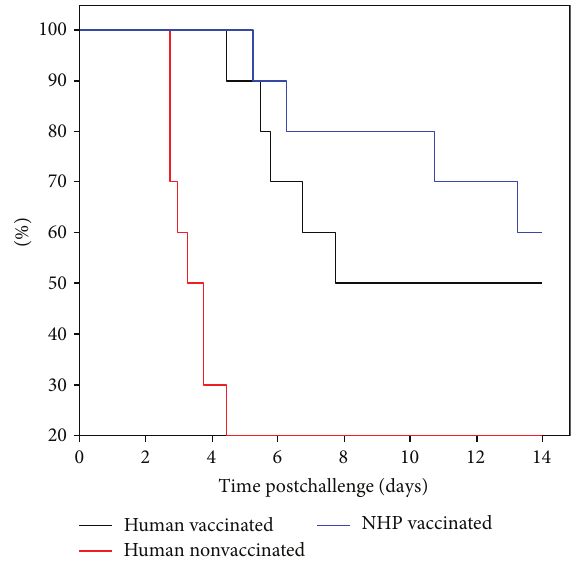
Figure 9: Passive immune therapy with NHP serum provided better protection in Hsd:NIHS mice than human serum after a lethal challenge of Y. pestis. Study (6), 𝑛 = 10 mice per group. Mice were administered 250 𝜇 L serum into the peritoneal cavity, 3–6 hours before being exposed to aerosolised Y. pestis using a modified contained Henderson apparatus. The MTD was calculated using a Kaplan-Meier survival